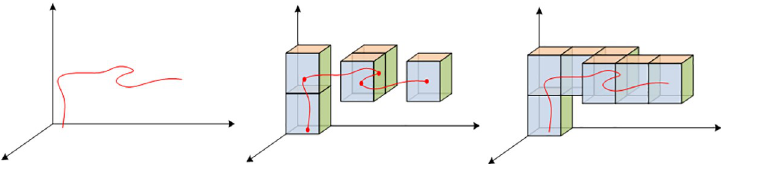
Fig 2. Construction procedure of one air route by